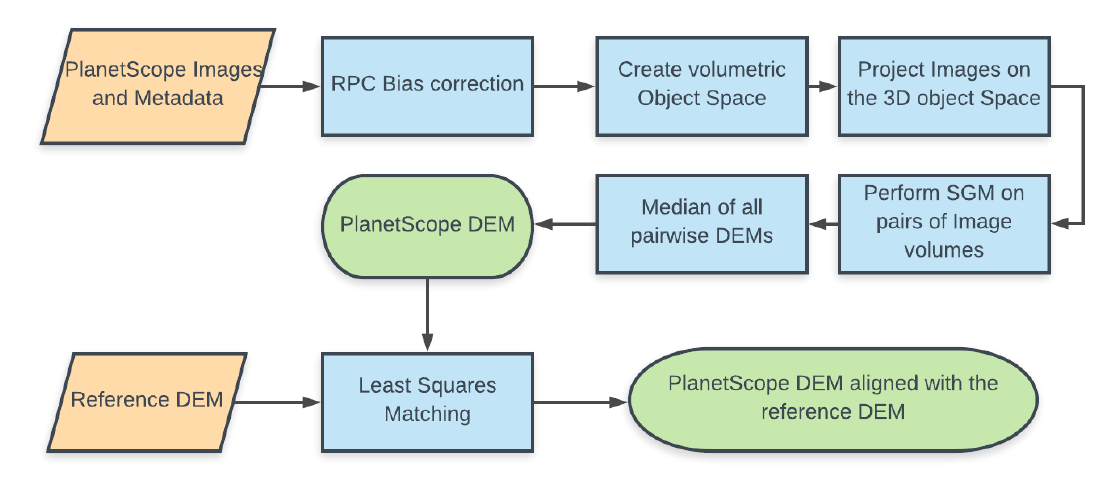
Figure 2. Flow Chart of the proposed